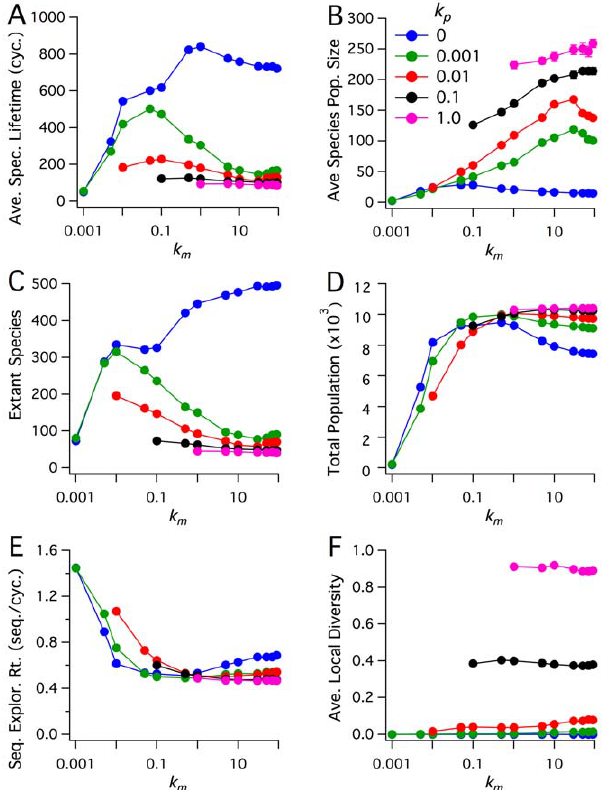
Figure 4. Exploring diffusive parameter space. Plots of quasi steady-state values of Average Species Lifetime (in units of number of cycles), Average Species Population, Extant Species, Total Population Size, Sequence Exploration Rate (in units of number of novel sequences generated per cycle), and Average Local Diversity. Time averages were taken from t ~ 2500 { 5000 cycles, and each point is the ensemble average over ten realizations. Error bars denote the sample standard deviation (most are smaller than symbols). The kinetic rate constants are k s ~ 10 { 7 , k r ~ 10 { 4 , and k h ~ 0 : 1 . The blue data set shows the case where the k p ~ 0 , where polymers are completely immobile.